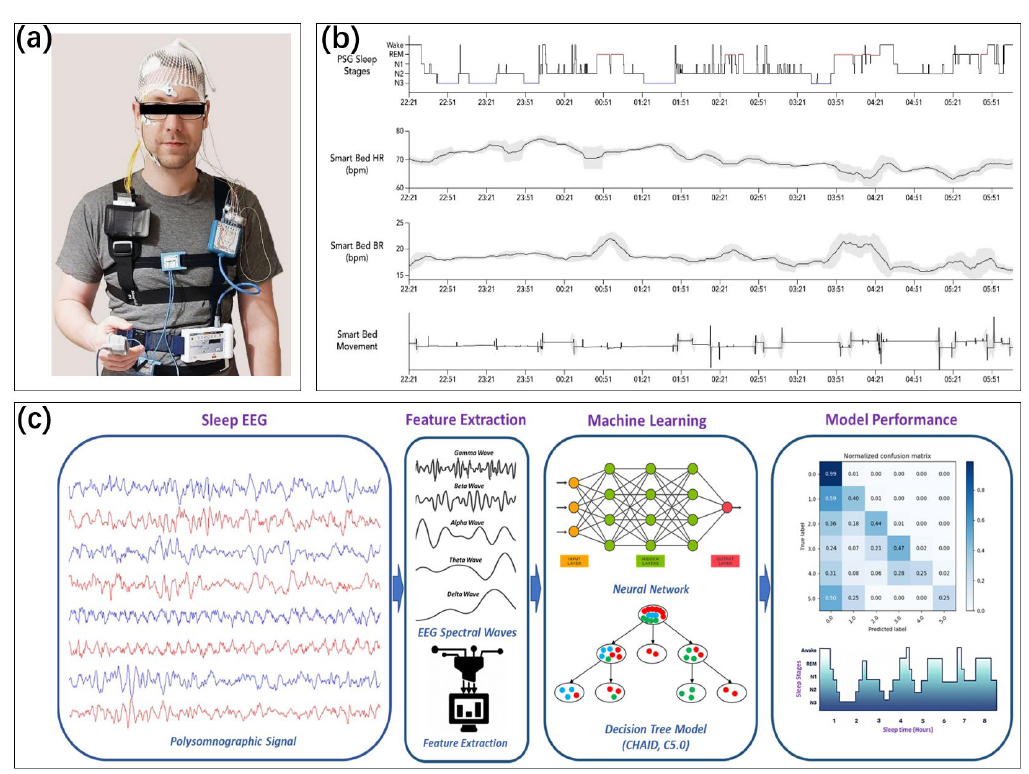
Figure 2. ( a ) The use of PSG [32,33]. Reproduced under the terms of the CC-BY Creative Commons Attribution License, Copyright 2022 by the authors, published by FRONTIERS MEDIA SA. ( b ) A home PSG that divides the sleep stages by monitoring several pieces of physiological information. Heart rate, respiratory rate, and movement are recorded and compared with the sleep cycle of a professional PSG [32,34] . Reproduced under the terms of the CC- BY Creative Commons Attribution License, Copyright 2022 by the authors, published by MDPI. ( c ) The principle of advanced polysomnography for sleep detection. Multichannel signals in PSG, after feature extraction, are analyzed using a machine-learning trained model. Sleep stage classification is performed [35] . Reproduced under the terms of the CC-BY Creative Commons Attribution License, Copyright 2022 by the authors, published by MDPI.